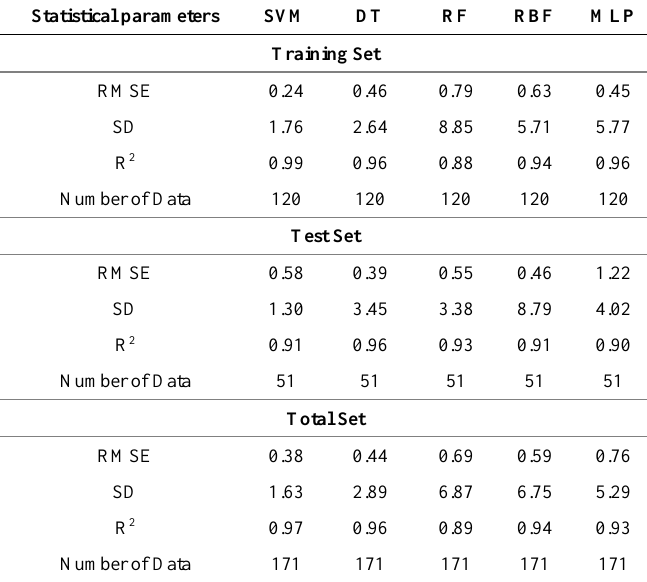
Table 3. Statistical parameter values for SVM, DT, RF, RBF, and